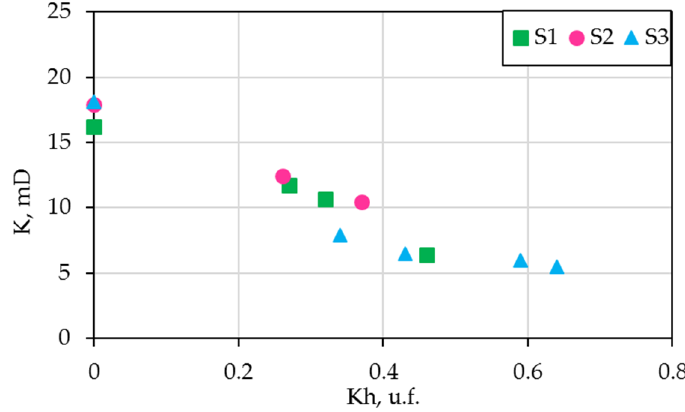
Figure 3. Effective gas permeability of frozen sand vs. CO 2 hydrate coefficient ( K h ) at − 5 °C.